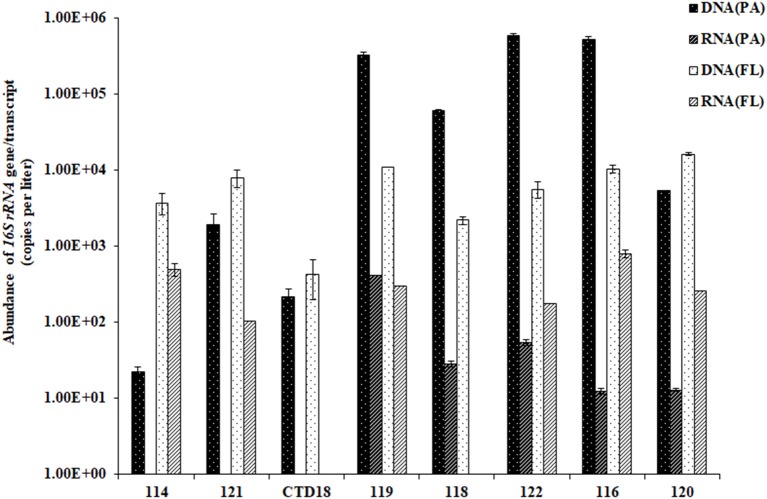
The abundances of the archaeal 16S rRNA gene sequences quantified by qPCR. Some of the RNA (PA) data were below the qPCR detection limit and are therefore not shown in the figure.